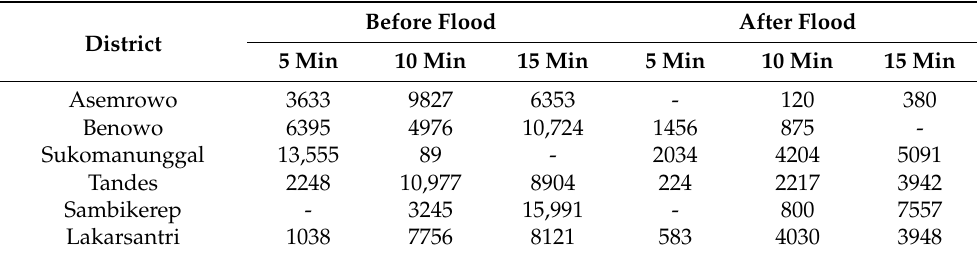
Table 5. The size of populations within healthcare service area by